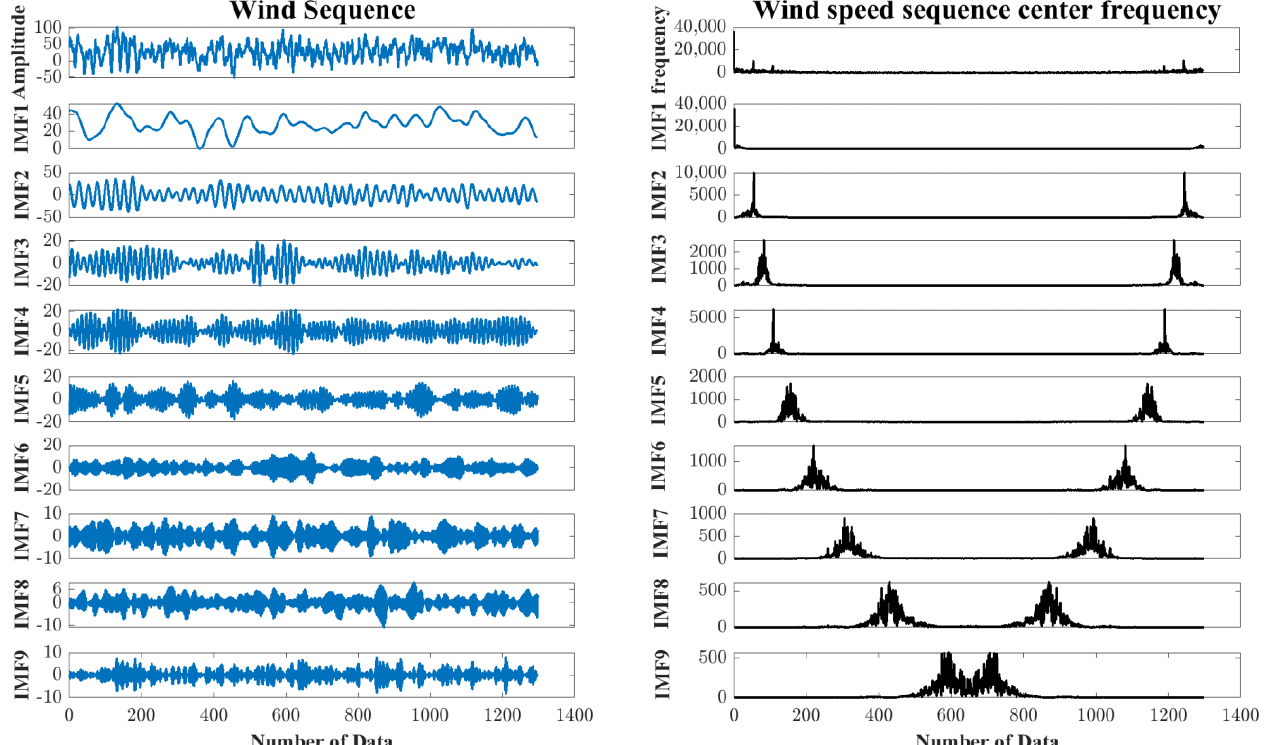
Figure 4. IMF components of wind speed sequence for the 86 km zonal wind (K = 9). The IMFs diagram are shown on the left, and the center frequency corresponding to the IMFs are shown on the right. Table 3. Best number of decompositions for 80 – 88 km meridional and zonal wind sequences.